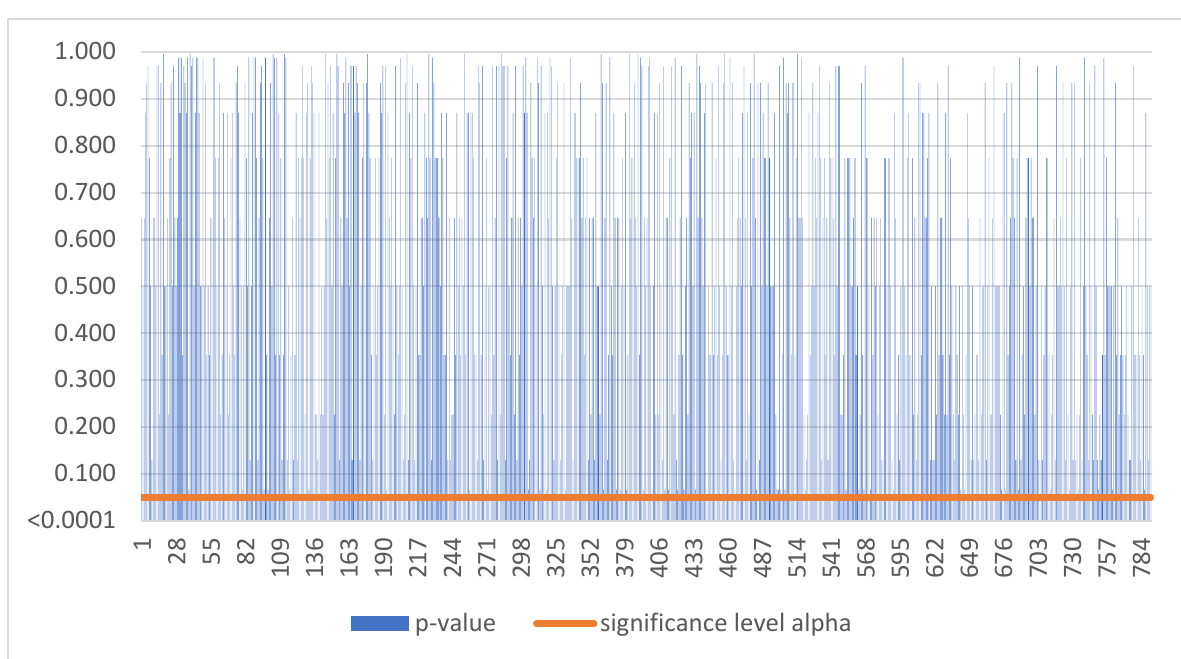
Figure 5. Negative trend in Poland.